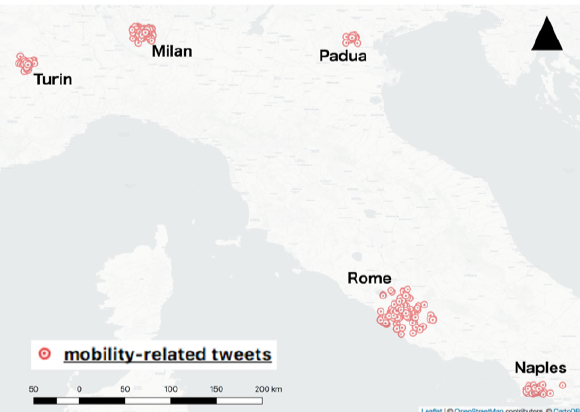
Figure 2. Map of mobility-related tweets extracted from the